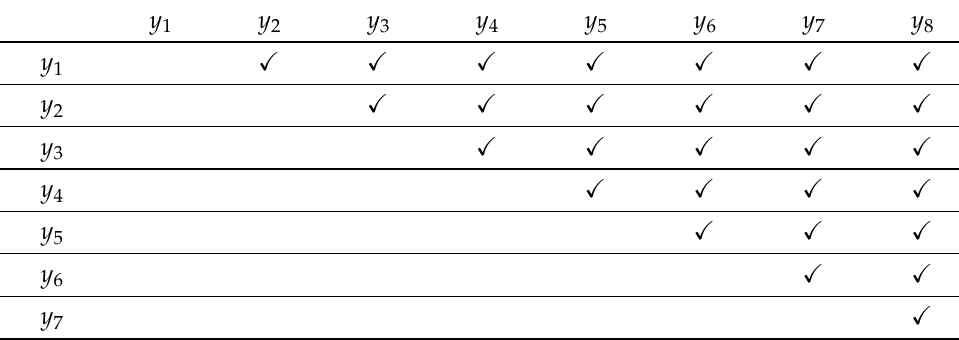
Table 3. The valid number of classifiers for one-versus-one SVM. y 1 y 2